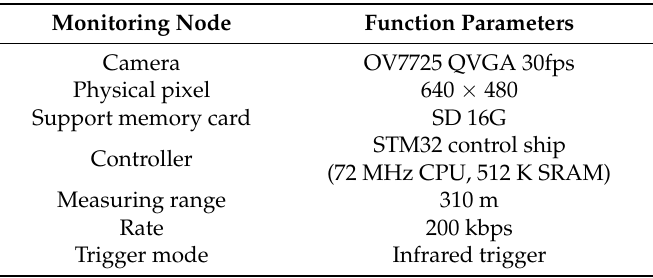
Table 1. Cont. Table 1. Parameters of wireless multimedia sensor network (WMSN) Node.